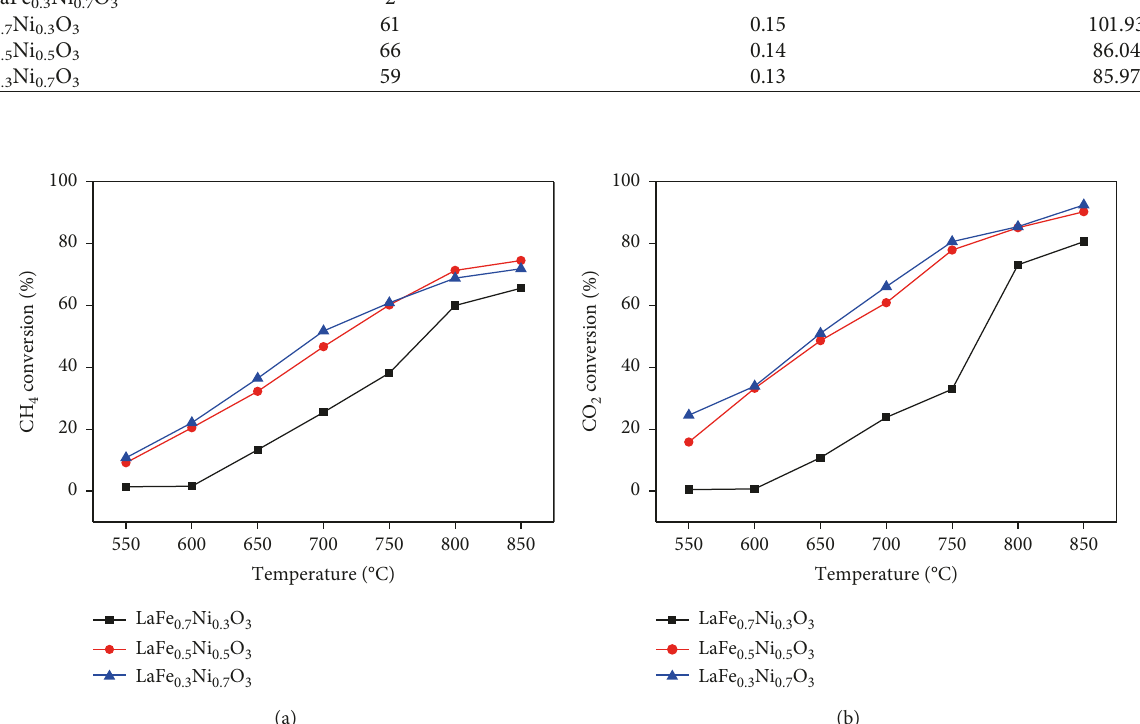
Figure 3: The conversions of CH 4 (a) and CO 2 (b) at different temperatures (CH 4 : CO 2 : N 2